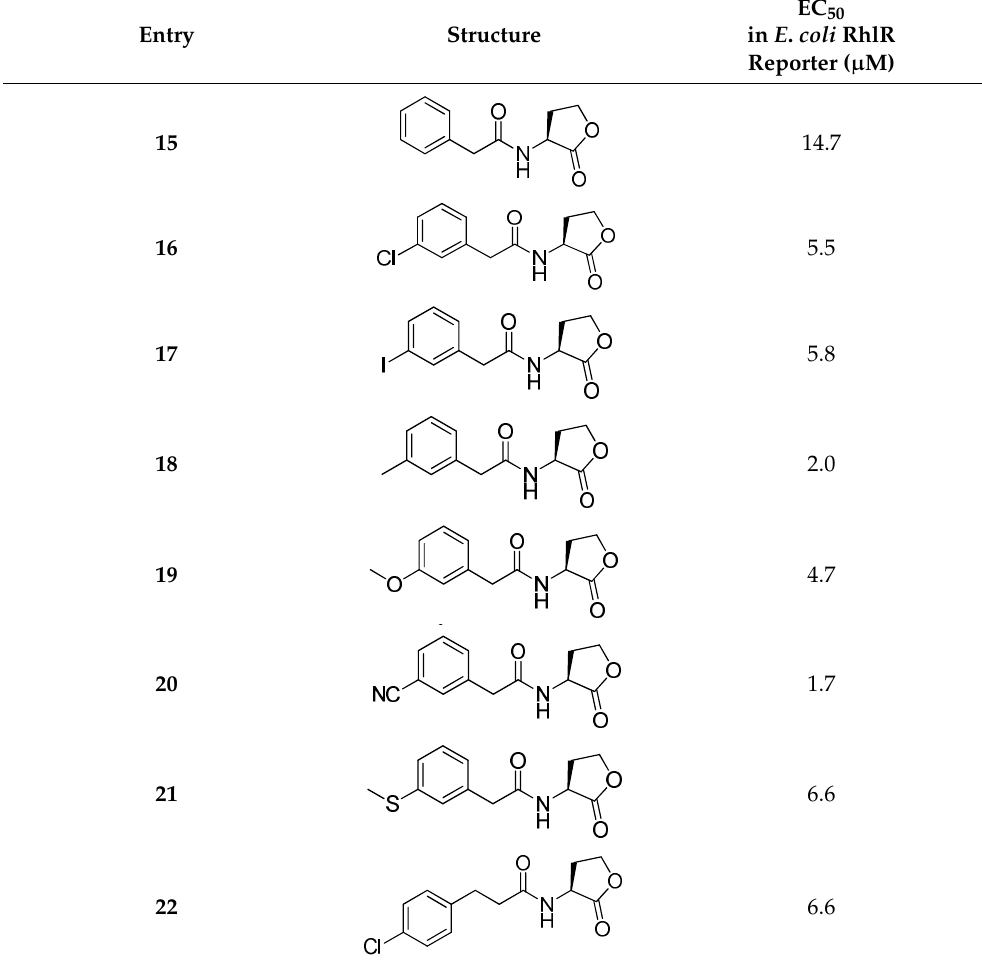
Table 2. RhlR-targeted agonists with variation of tail region.